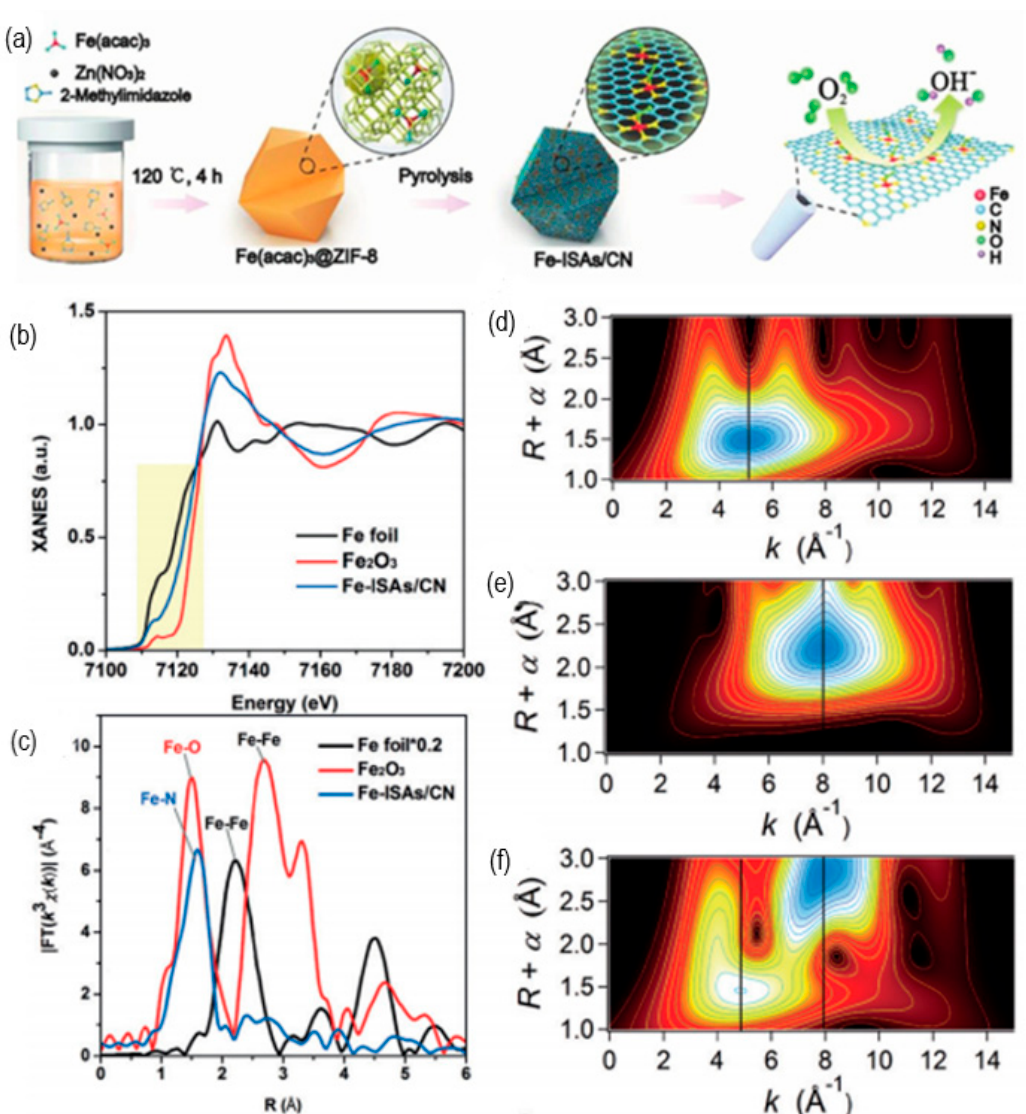
Figure 5. Space Constraint Strategy. ( a ) Schematic diagram of Fe − ISAS/C − N preparation by space constraint strategy; ( b ) X − ray absorption near edge structure (XANES) spectra (yellow region highlights near side energy absorption); ( c ) corresponding X − ray absorption fine structure (EX- AFS) curves of Fe − ISAS/C − N; and Fe K − edge Fourier transform (FT) and Wavelet transform (WT) for ( d ) Fe − ISAS/C − N, ( e ) Fe foils, and ( f ) Fe 2 O 3 samples. Reproduced with permission from Ref. [53], John Wiley & Sons Ltd.: 2017.